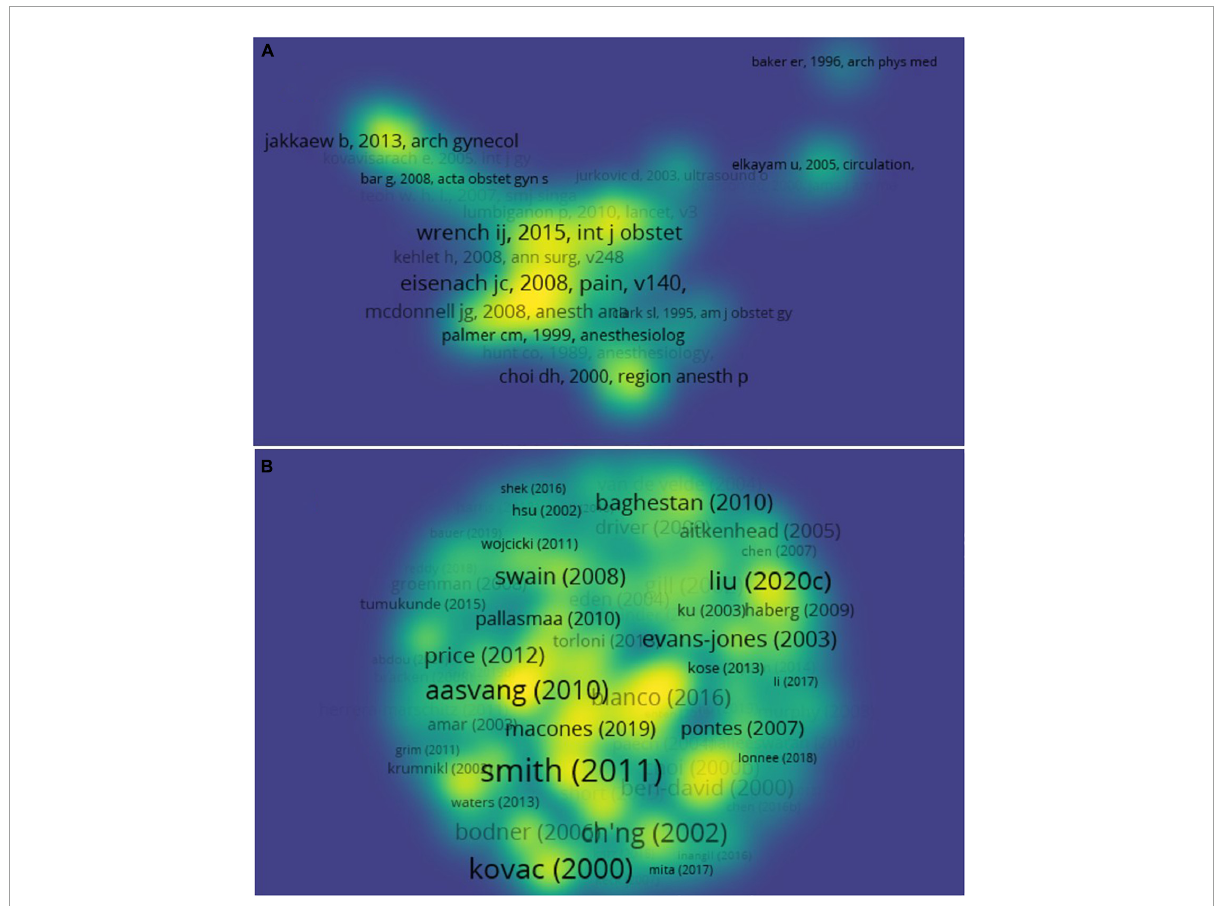
FIGURE4 Citation analysis of documents. (A) The co-citation map of 1,272 cited references was generated. (B) The citation map of